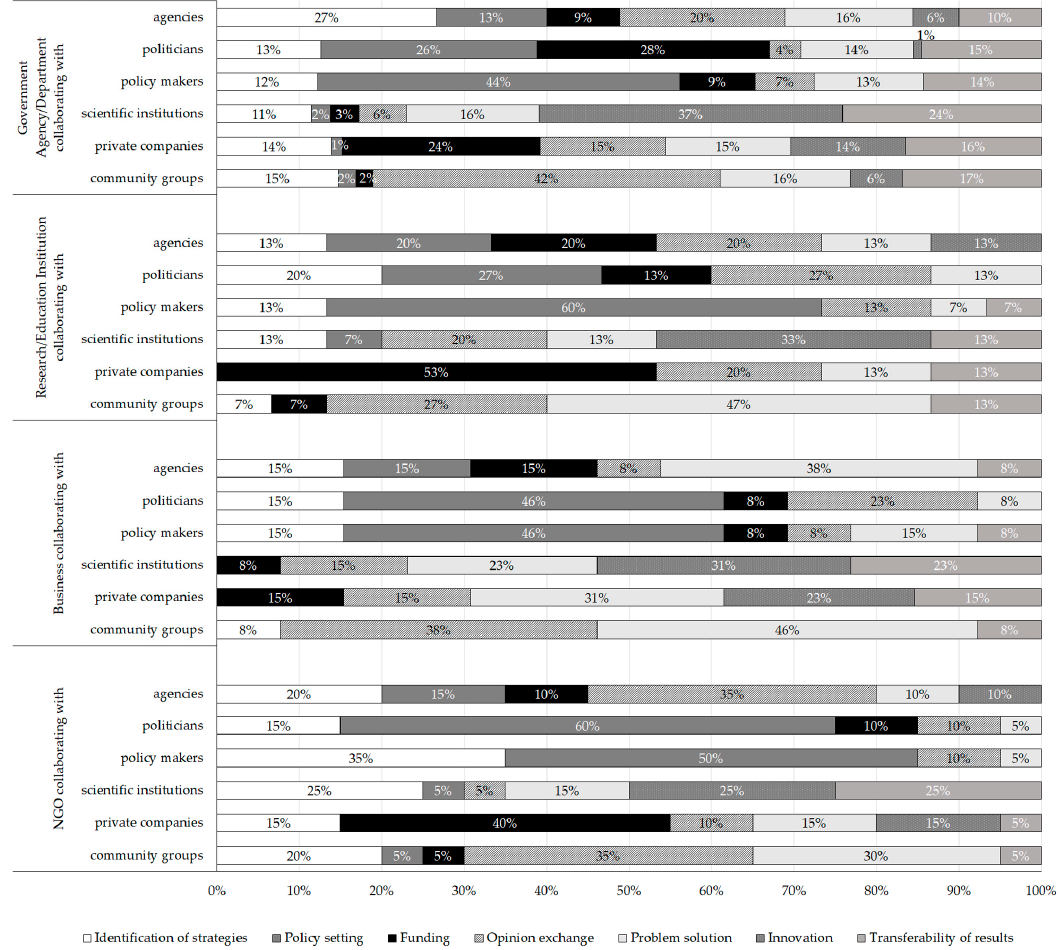
Figure 6. Benefits from collaborations with other categories. Percentages of selection of the suggested benefit given by each category of respondent ( n = 137).